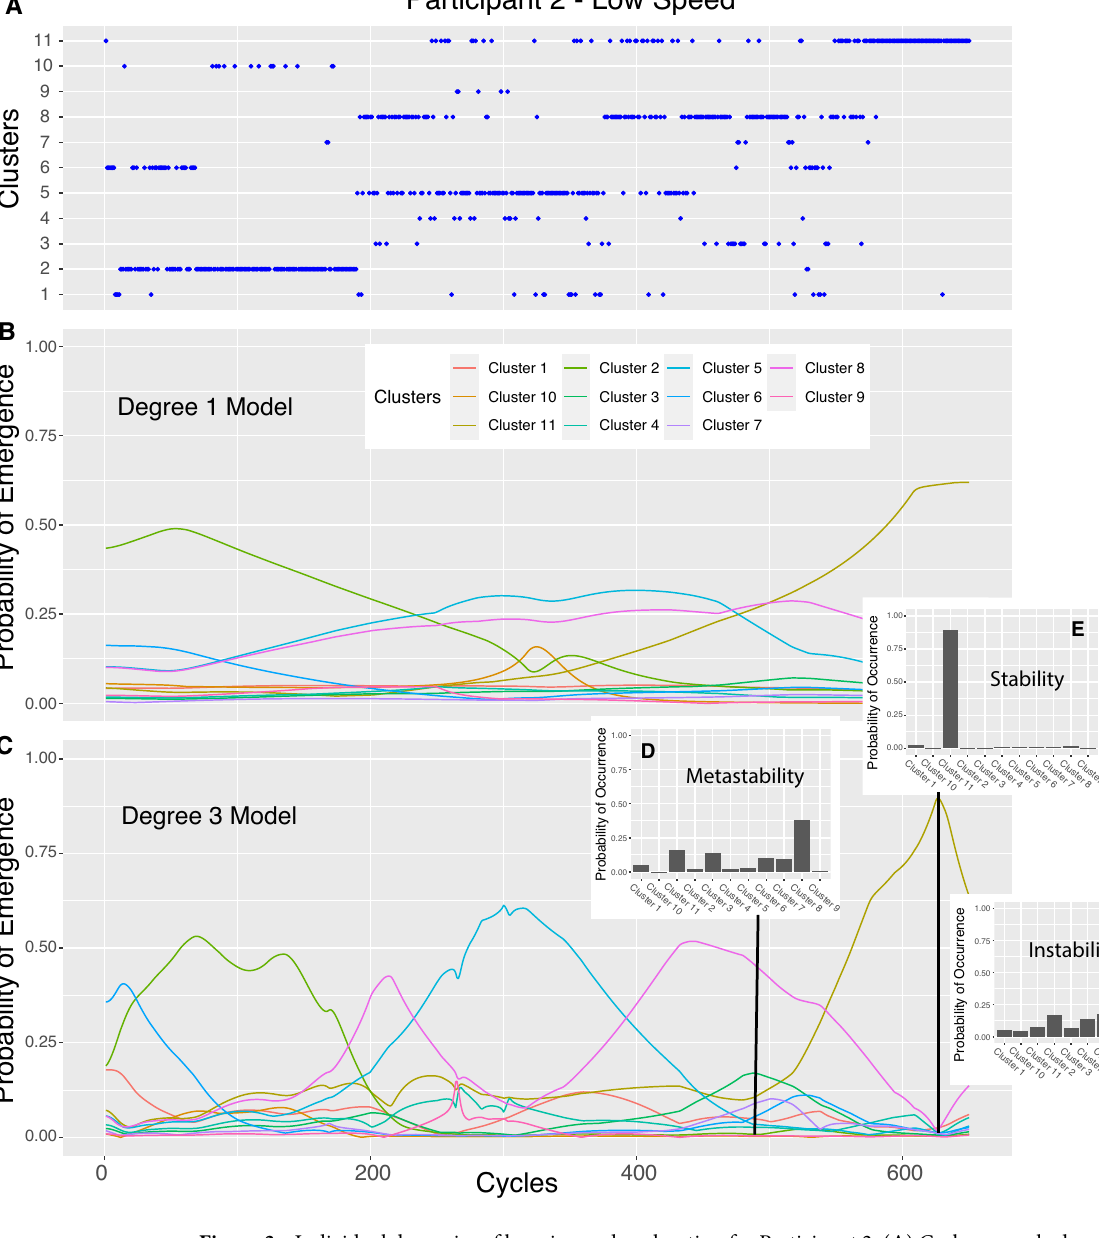
(Fig. 4B). More precisely cluster 6 and cluster 2 were explored more than others in the high-speed condition whereas clusters 8, 9 and 10 appeared less explored. Conversely, in the low-speed condition, only two significant differences between the quantity of exploration of clusters appeared (Figs. 4 and 5 for the individual distribution